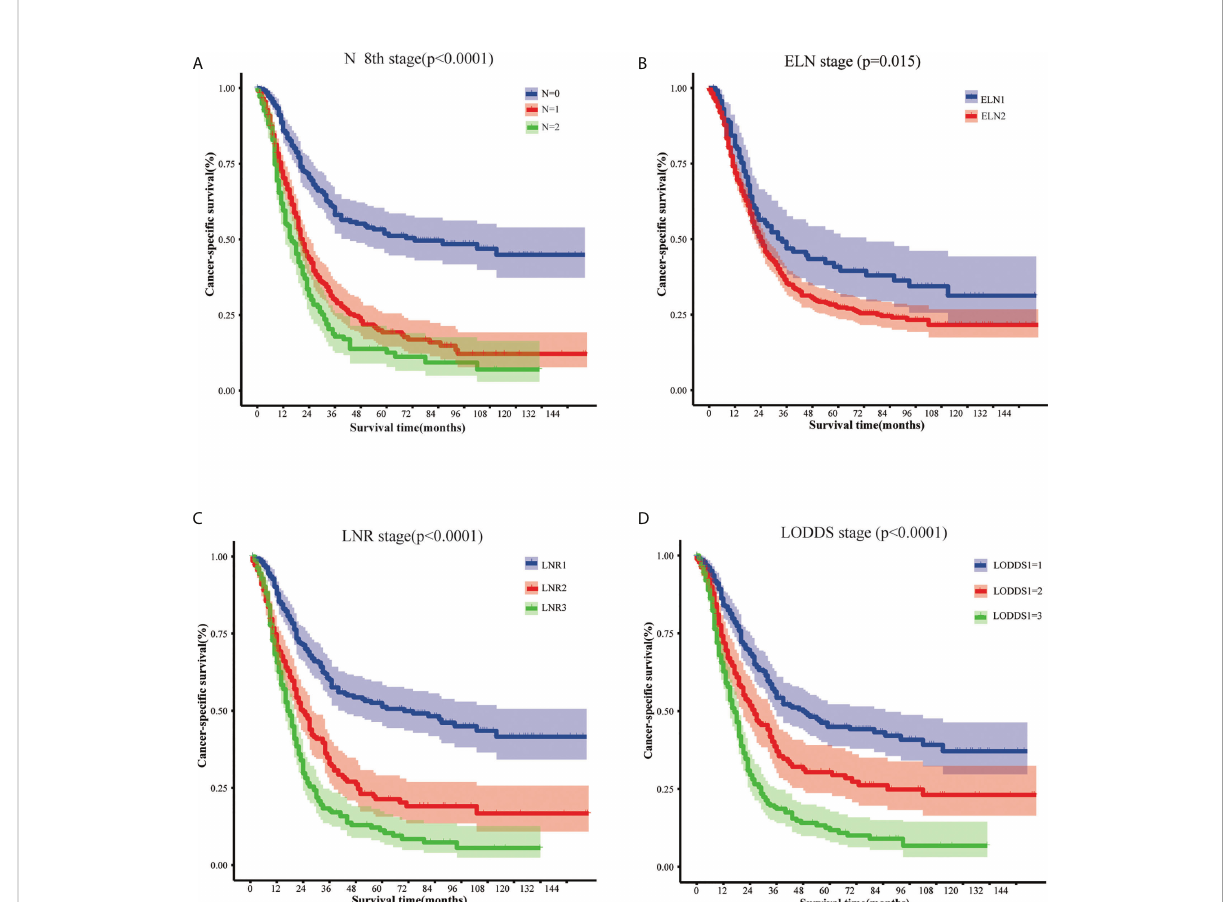
FIGURE 1 The cancer-speci fi c survival of early-onset pancreatic cancer patients who underwent surgery strati fi ed by different lymph node classi fi cations: (A) 8th AJCC N stage, (B) the ELN stage, (C) the LNR stage, and (D) the LODDS stage. AJCC, American Joint Committee on Cancer; ELN, examined lymph nodes; LNR, lymph node ratio; LODDS, log odds of positive lymph